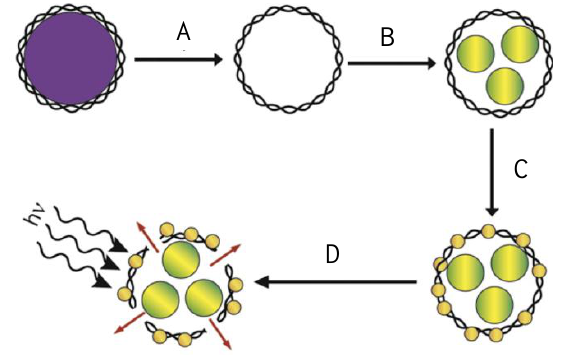
Figure 9. Photothermal effect of gold nanoparticles for releasing encapsulated materials: (A) Polyelectrolyte capsule prepared by layer-by-layer process; (B) Encapsulation of pharmaceuticals; (C) Doping of AuNPs in the shells of capsule; (D) Rupture of the shell upon light irradiation. Reproduced with permission from [2] ® 2008,